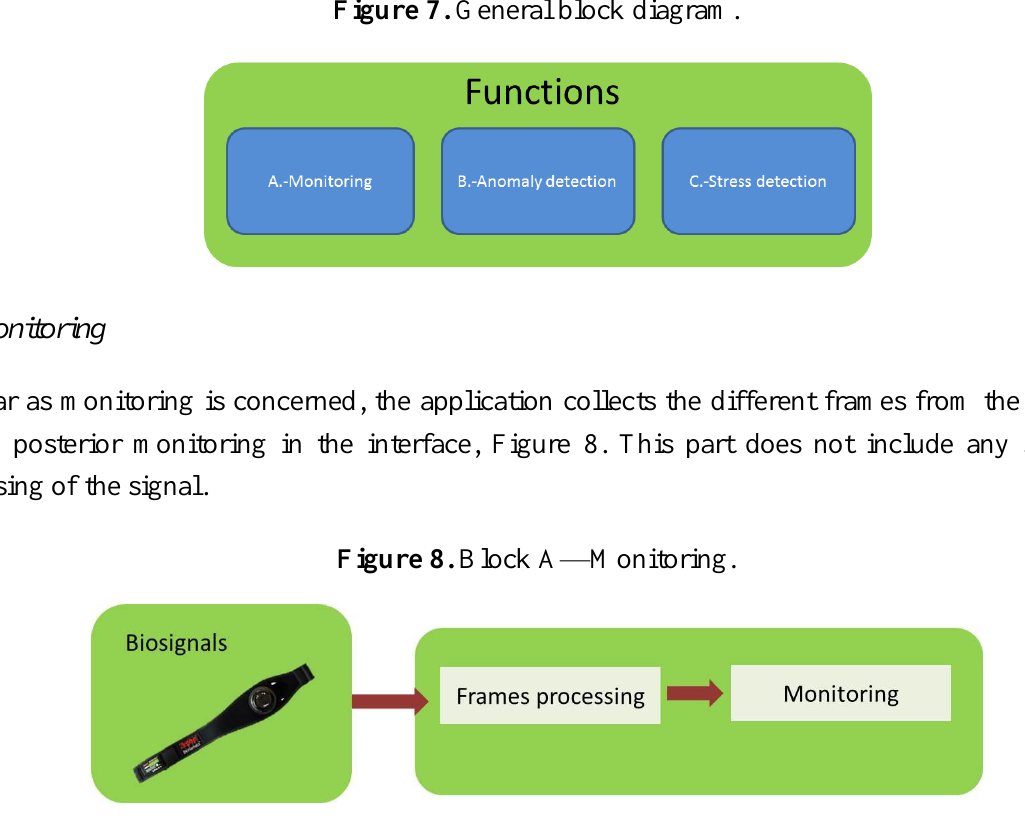
Figure 7. General block diagram.